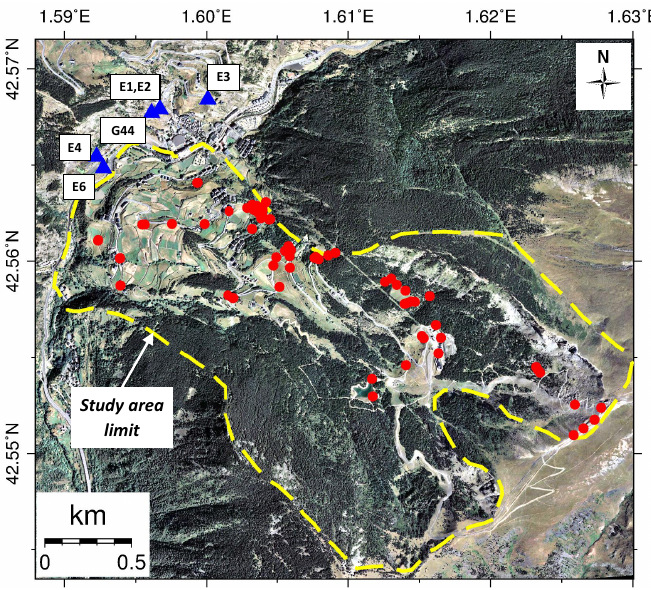
Figure 3. The locations of the GPS measurement points. The filled-in blue triangles and red circles indicate the GPS base points and control points,